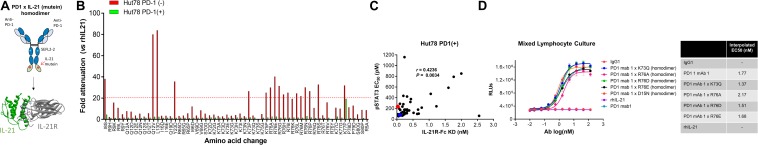
Anti-PD-1 × IL-21 fusion proteins with attenuated IL-21 activity. (A) Schematic representation of fusion protein domain assembly. (B) IL-21 activity of fusion proteins (tested at 3.7 nM) monitored by STAT3 phosphorylation using AlphaLISA in variants of Hut78 T cells either parental PD-1 (–) or engineering PD-1 (+) cells. Activity of muteins expressed relative to WT recombinant human IL-21 as a measure of attenuation. (C) Correlation between potency monitored using STAT3 phosphorylation in PD-1 (+) Hut78 T cells (monitored by AlphaLISA) and binding (determined by Octet) to human IL-21R. P-value for c Pearson correlation co-efficient, P = 0.0034 and r = 0.4236. (D) Potency of single amino acid substitution IL-21 variants fused to anti-PD-1 mAb as homodimer and parental mAb in blocking PD-1/L1 interaction monitored using Promega PD-1/L1 bioassay.